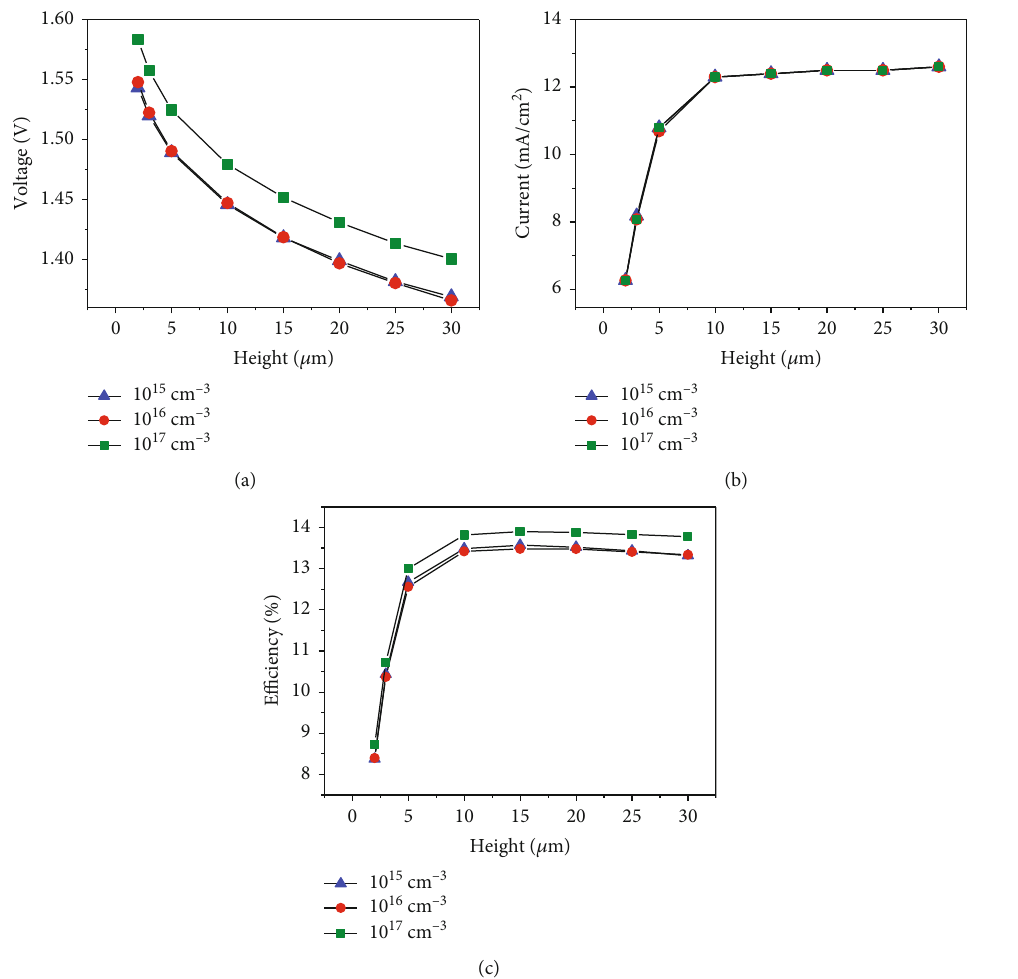
ffi ciency on the height of the Si wire for di ff erent doping levels; the MCC lifetime is Figure 9: Dependences of (a) V OC , (b) J SC , and the (c) e 10 μ s, and the wire diameter is 0.5 μ